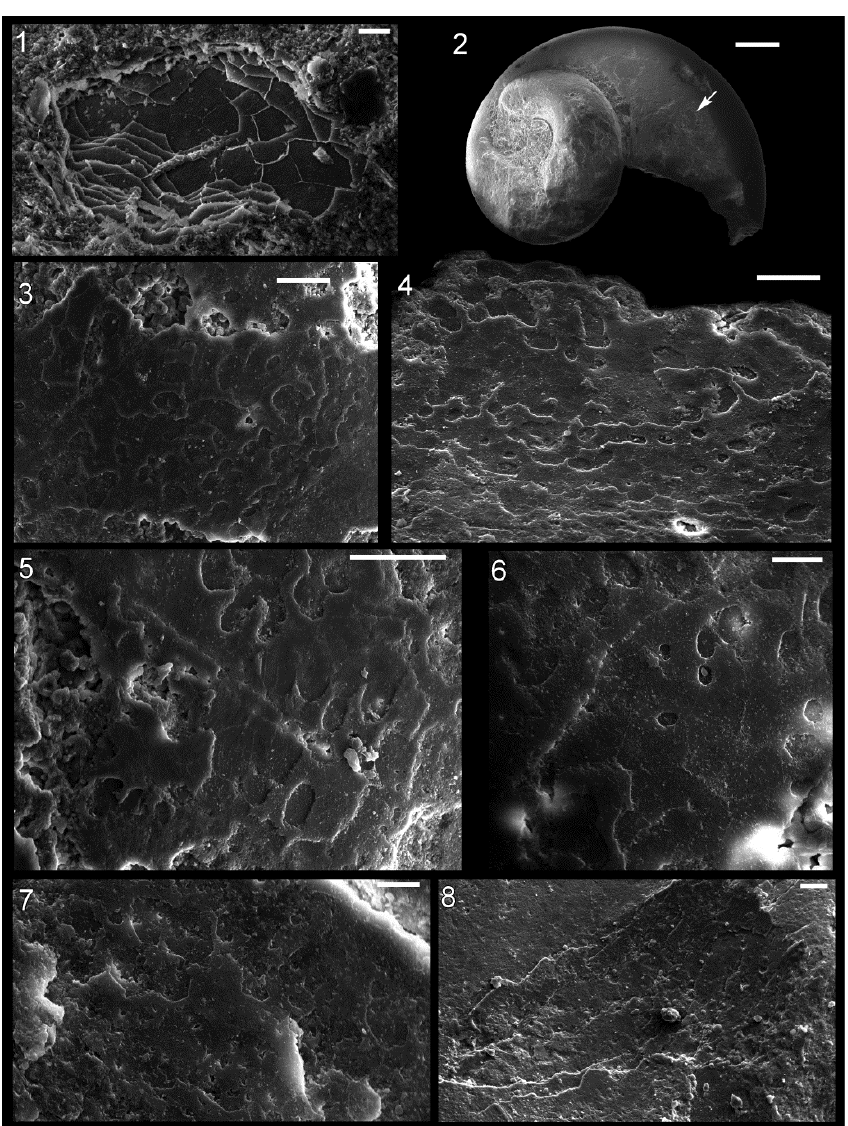
Figure 9. Shell microstructures in a specimen of the gastropod Cyclora ( Cyclonema ?) ( 1 ) and ( 2 ); the bivalves Palaeoconcha sp. ( 3 )–( 7 ); and the bellerophont Cyrtolites sp. ( 8 ) from Ordovician localities around Cincinatti, Ohio. ( 1 ) and ( 2 ) LACMIP 14444, from the Fairview Formation near Dearborn/Lawrenceburg, Indiana, arrow in ( 2 ) shows location of ( 1 ); ( 3 )–( 6 ) LACMIP 14445, from the Fairview Formation near Dearborn/Lawrenceburg, Indiana: ( 3 ) horizontal view of surface of internal mould near midpoint of valve; ( 4 ) horizontal view of surface of internal mould near aperture (broken aperture mould at top of photo); ( 5 ) horizontal view of surface of internal mould near umbo; ( 6 ) horizontal view of surface of internal mould near midpoint of valve; ( 7 ) LACMIP 14446, from the “Arnheim Formation” along Kemper Road, Cincinnati, Ohio , horizontal view of surface of internal mould in region between midpoint of valve and umbo; and ( 8 ) LACMIP 14447, from the “Arnheim Formation” in Middletown, Ohio, horizontal view of internal mould or thin shell replacement near columellar side of aperture, imaginary line normal to plane of aperture would extend diagonally down/leftward on the photo. Scale bars: 10 µm for ( 1 ), ( 6 ) and ( 7 ); 200 µm for ( 2 ); and 20 µm for ( 3 )–( 5 ) and ( 8